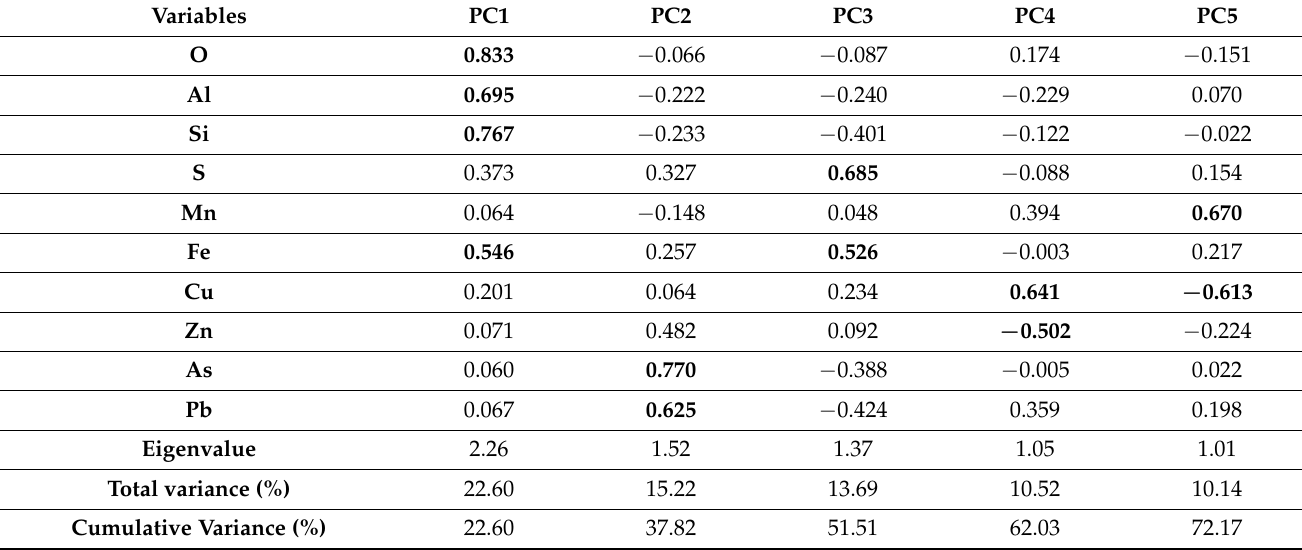
Table 4. Results of principal component analysis (PCA) of data from chemical composition of PM 10 analyzed in SEM-EDX.